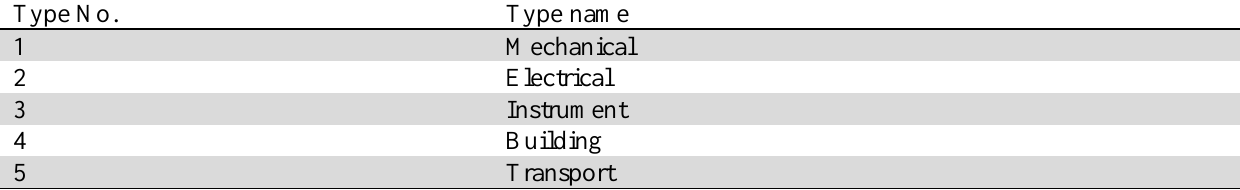
Types of tasks (operations) Type No.